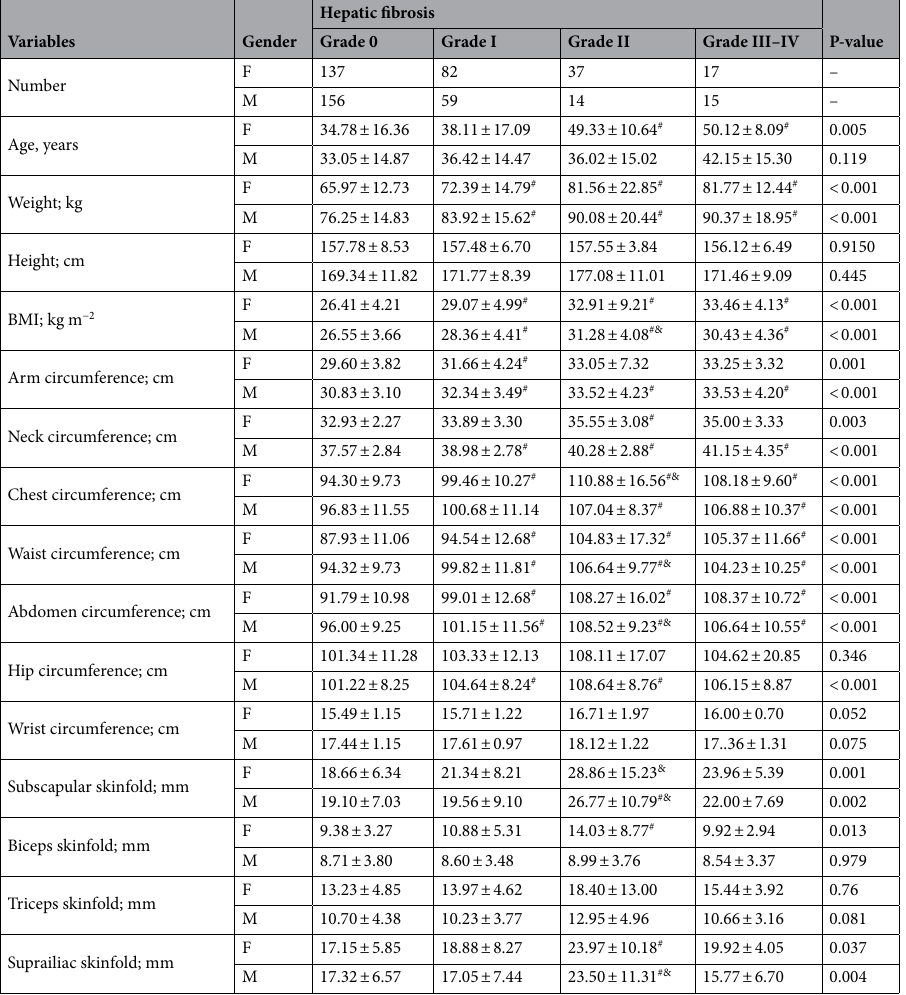
Table 3. A comparison of the anthropometric variables across different stage of the hepatic fibrosis in male and female participants. BMI body mass index. Data are presented as means ± standard deviations. P values were obtained from analysis of variance (ANOVA), followed by Tukey’s post hoc test. # Significant difference (P < 0.05) compared with grade 0; & Significant difference (P < 0.05) compared with grade 1; $ Significant difference (P < 0.05) compared with grade